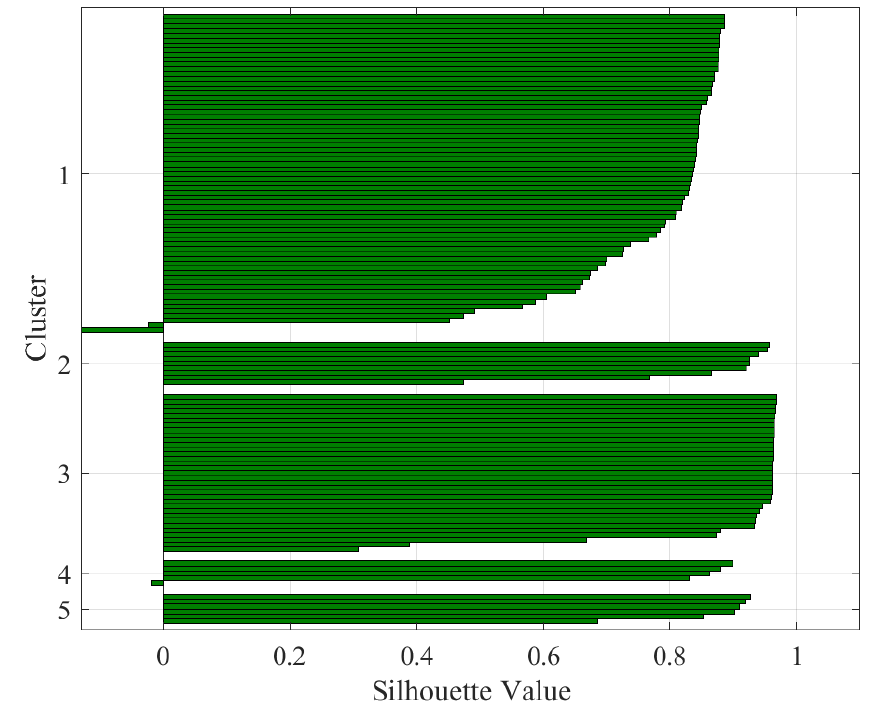
Figure 9. Silhouette plot of clustered rotor harmonics data with k = 5.